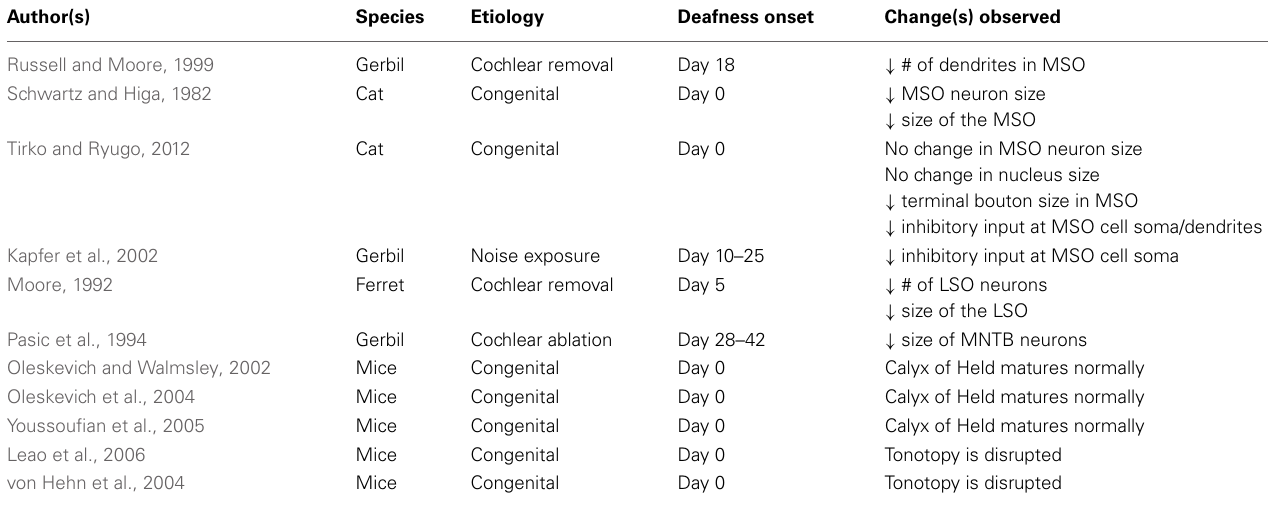
Table 2 | Summary of changes in superior olivary